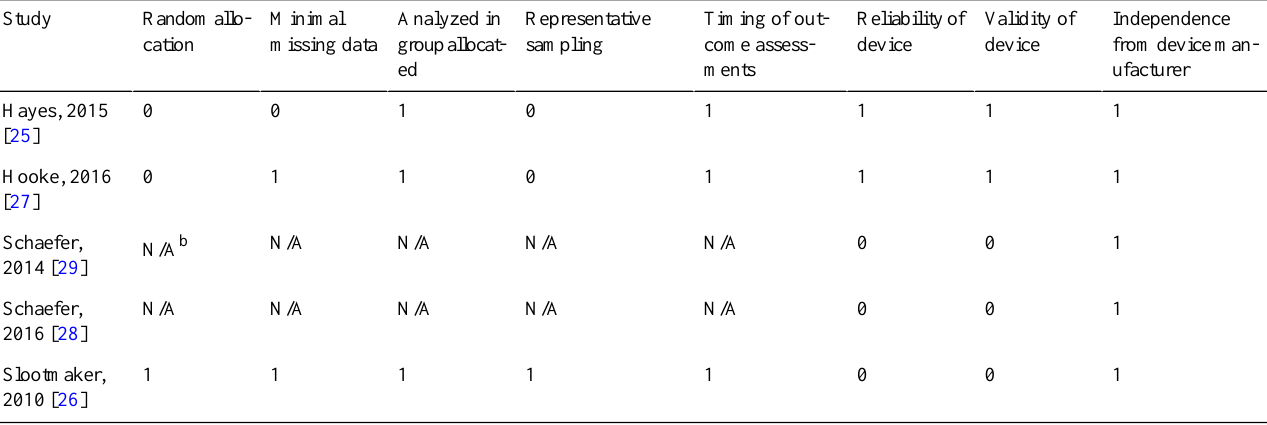
Table 3. Risk-of-bias results a in studies on the effectiveness and feasibility of wearable activity trackers in